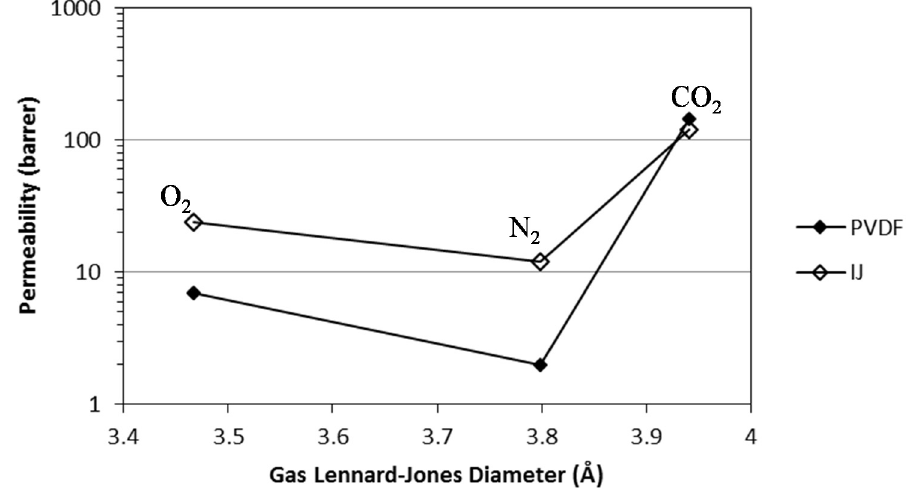
Figure 1. Comparison of the gas permeabilities of the PVDF and Ion-Jelly ® [23] membranes as a function of the gas Lennard-Jones